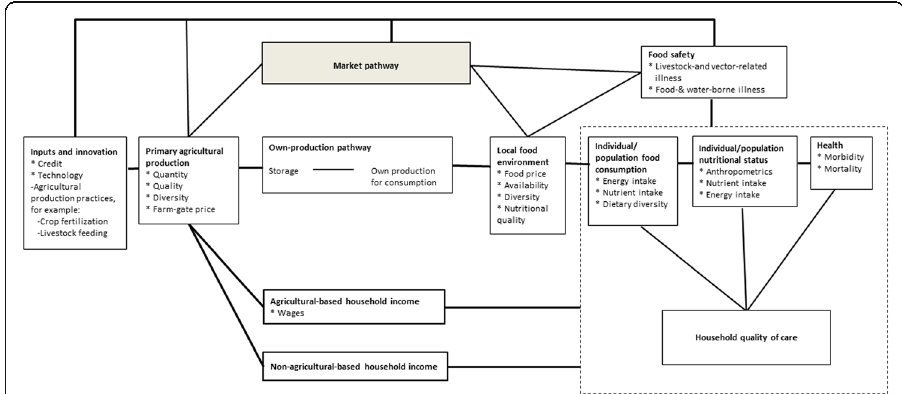
Fig. 1 Conceptual framework of the links between agriculture, the food system, nutrition, and public health. Source: Adopted from Kanter et al.